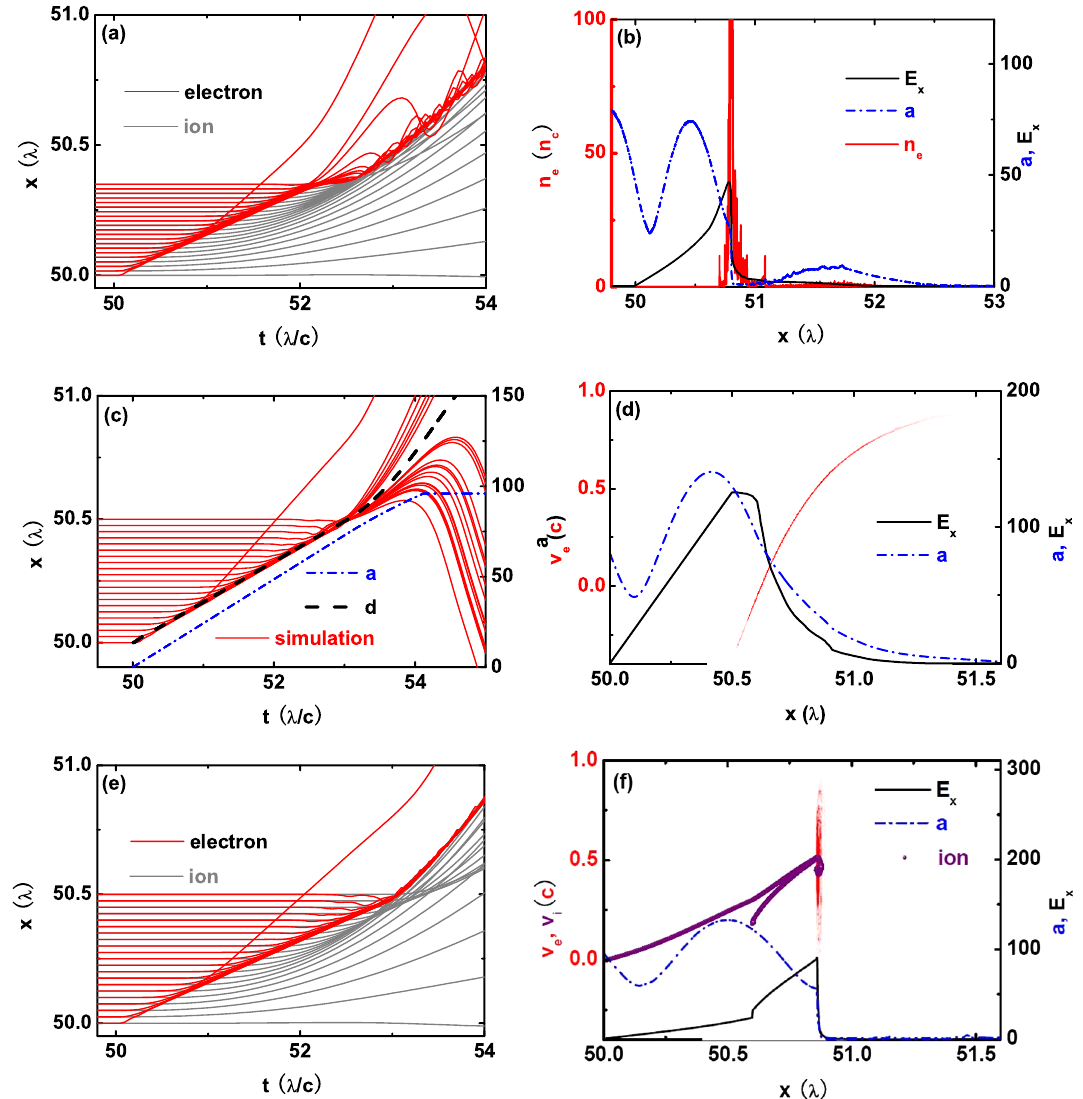
FIG. 5. 1D simulations for (a) and (b) a 0 ¼ 50 and l 0 ¼ 0 : 35 (cid:3) , and (c)–(f) a 0 ¼ 96 and l 0 ¼ 0 : 5 (cid:3) . Here a 0 =t up ¼ 29 and n 0 ¼ 40 n c . The ions are fixed in (c) and (d), and moving in (a), (b), (e), and (f). Red solid lines in (a), (c), and (e) denote electron trajectories. Gray solid lines in (a) and (e) denote ion trajectories. CEL positions (dashed line) and incident laser amplitudes on the CEL surface a (dash dotted line) from the analytical model are plotted in (c). Phase-space distribution of electrons at 54 T for (d) fixed and (f) moving ions (purple circles) are shown. E x (black solid line) and a (blue dash dotted line) in simulation are